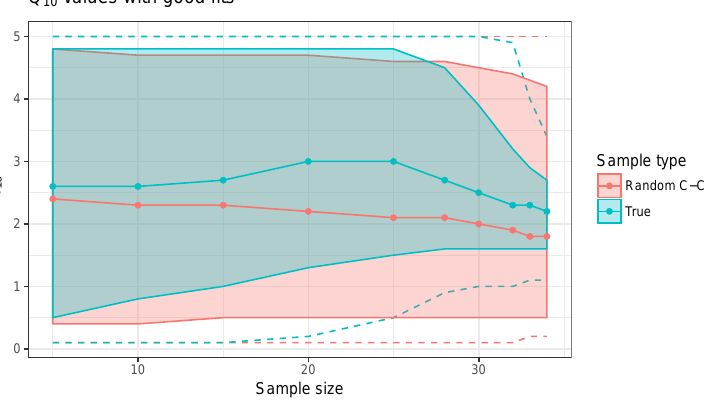
Figure 2. The Q 10 with good one-to-one model–data fits defined in Fig. 1, at 90% confidence interval (band) with minimum and maximum values (dotted line) and median value (solid line), across 10 different sample sizes ranging from 5 to 34, for the original data set (true: blue) and randomized case–control (random C-C: